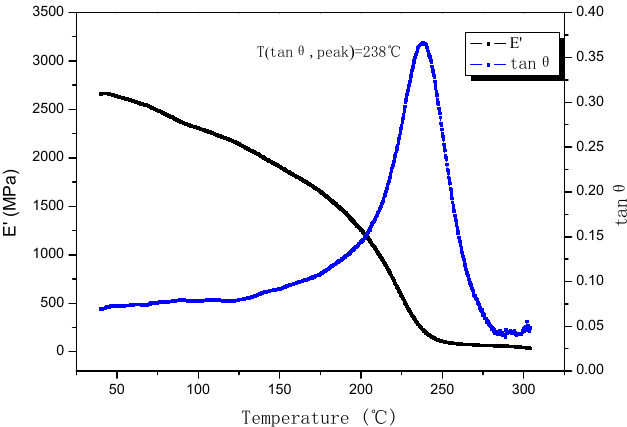
Figure 2. Dynamic mechanical test curves of the rosin-sourced epoxy cast bar.